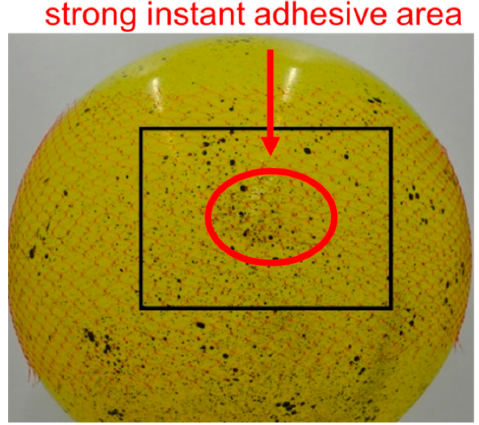
Figure 11. Measurement around no deformation.